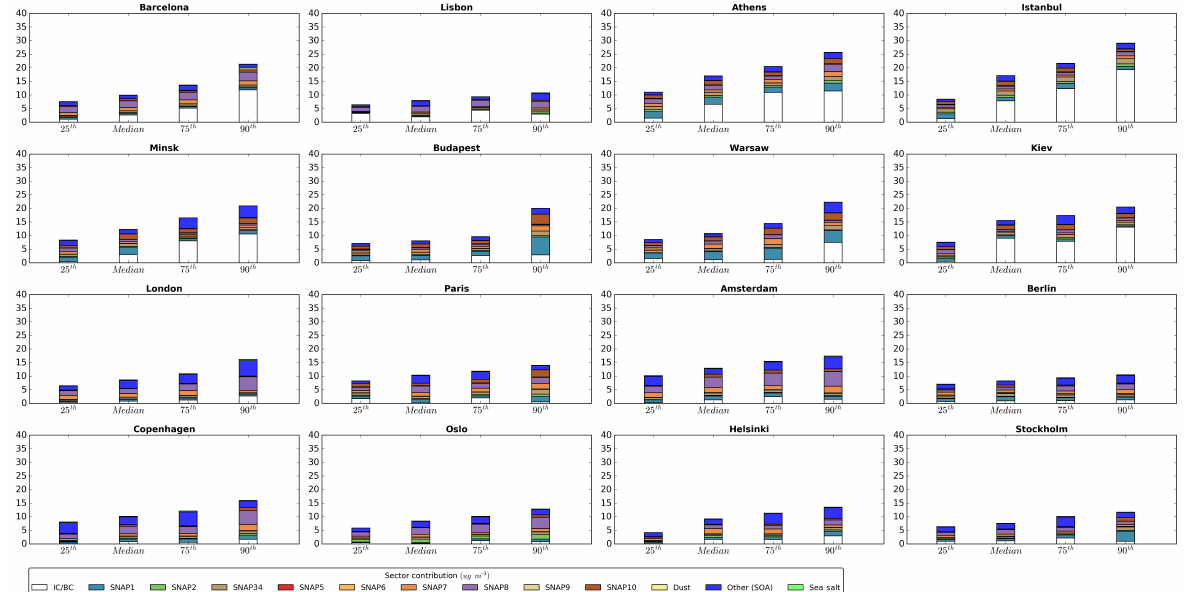
Figure 9. Source attribution results for the distribution of summertime daily PM 2 . 5 concentrations for the 16